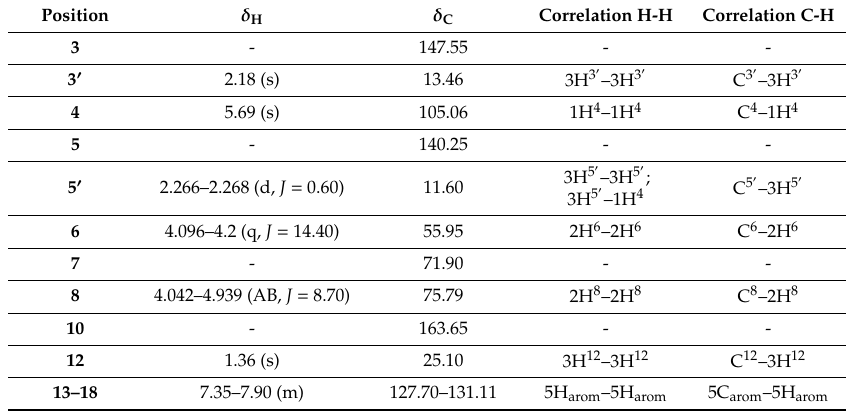
Table 1. (300.13 MHz) and 13 C (75.47 MHz) NMR spectral data for compound 2 in CDCl 3 , including results obtained by homonuclear 2D shift-correlated and heteronuclear 2D shift-correlated HSQC ( 1 𝐽 CH ). Chemical shifts ( δ in ppm) and coupling constants ( 𝐽 in Hz).